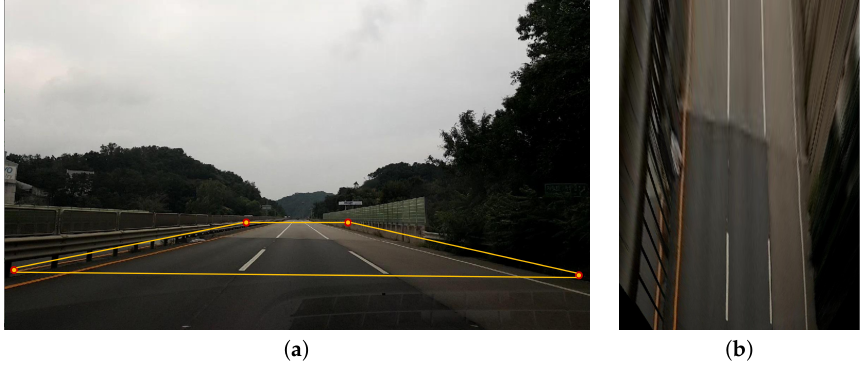
Figure 3. Sample inverse perspective mapping (IPM) image: ( a ) original image; ( b ) IPM